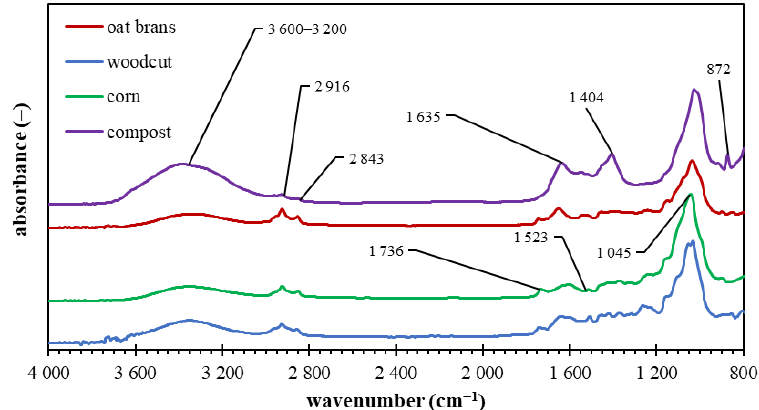
Figure 1. FTIR spectra of the individual biomass feedstocks.